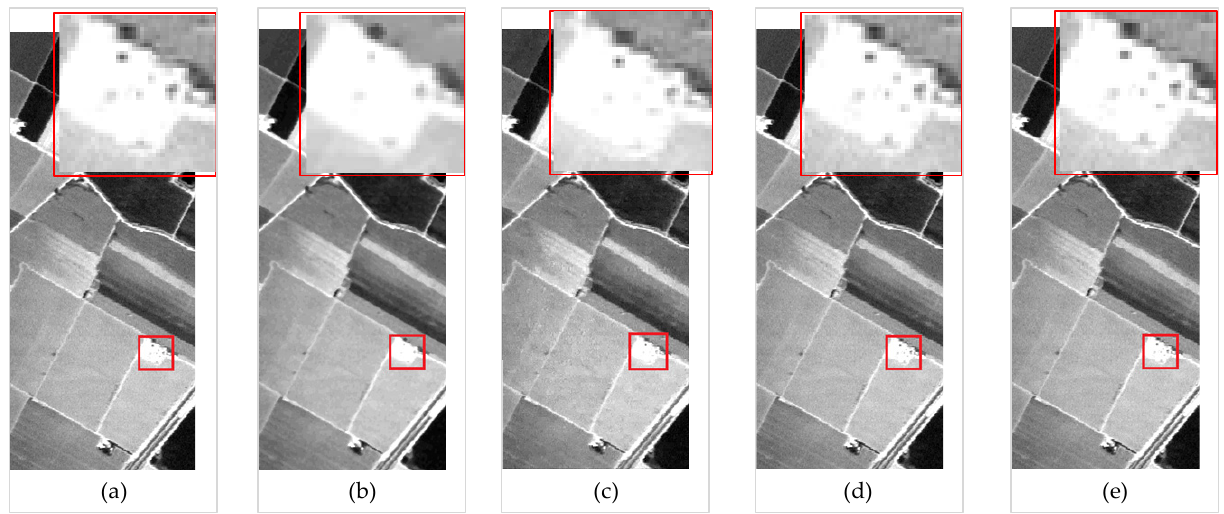
Figure 5. The denoising results of band 5 in Salinas. ( a ) Original image; ( b ) denoised result of KMNF-NE; ( c ) denoised result of SSDC; ( d ) denoised result of MNEM-Order; ( e ) denoised result of MNEM-Ratio.